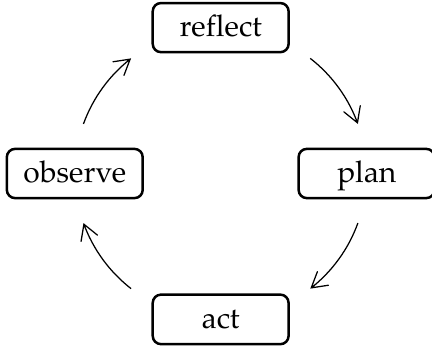
Figure 2. Four moments of action research (plan, act, observe, reflect).